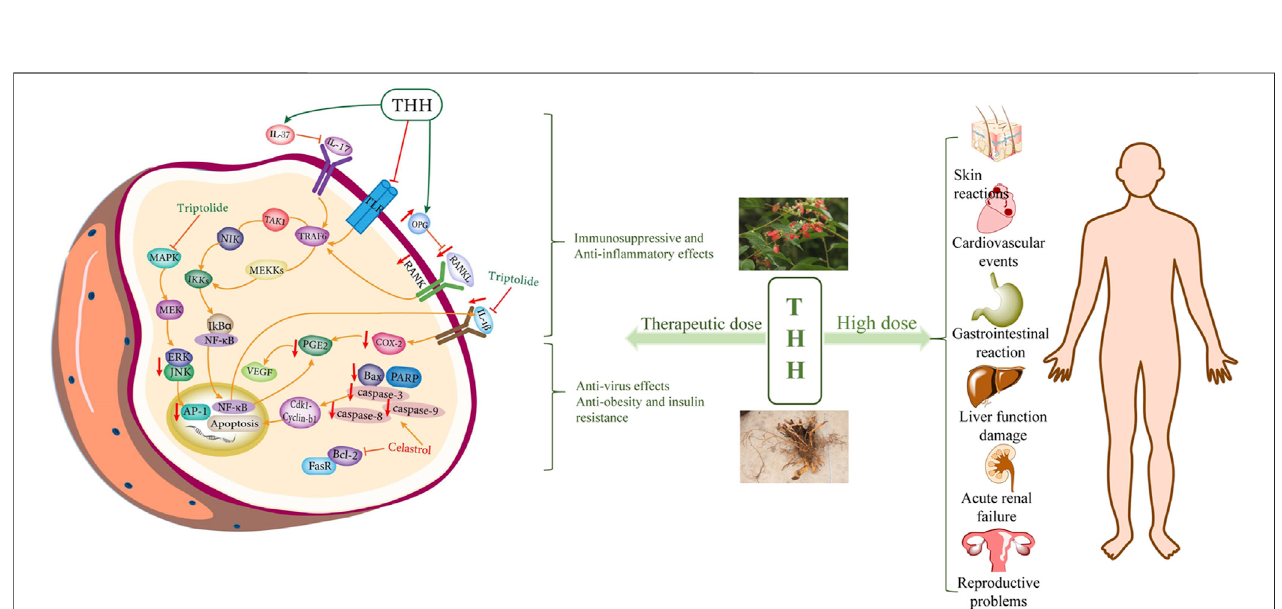
FIGURE 5 | Illustration of the main signalling pathways involved in THH-based therapy and organ toxicities observed at high doses.